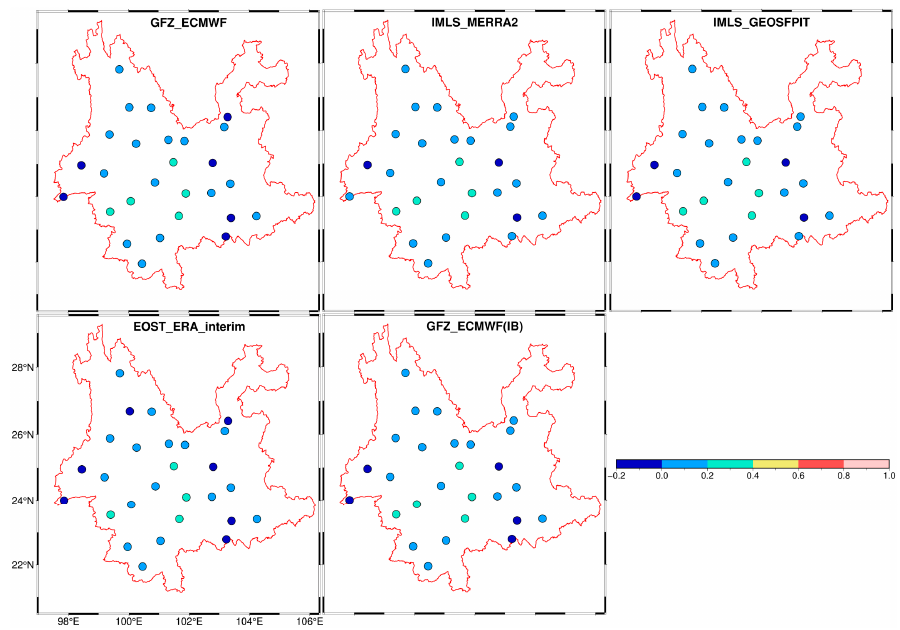
Figure 6. The correlation between five ATML products and vertical GPS time series at 27 GPS stations.